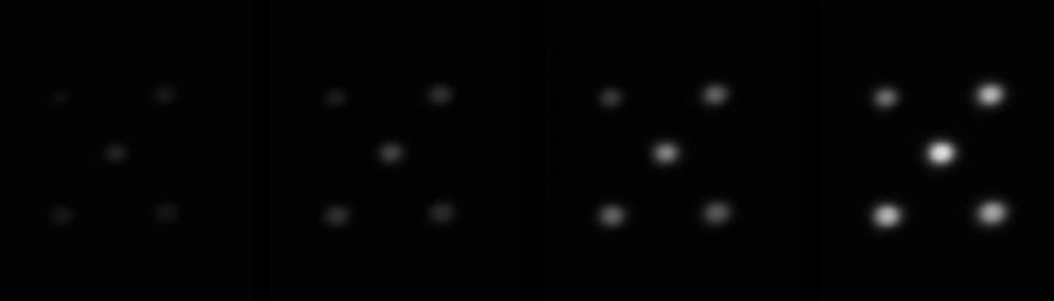
Figure 6. The correction file from the light intensity sensor.